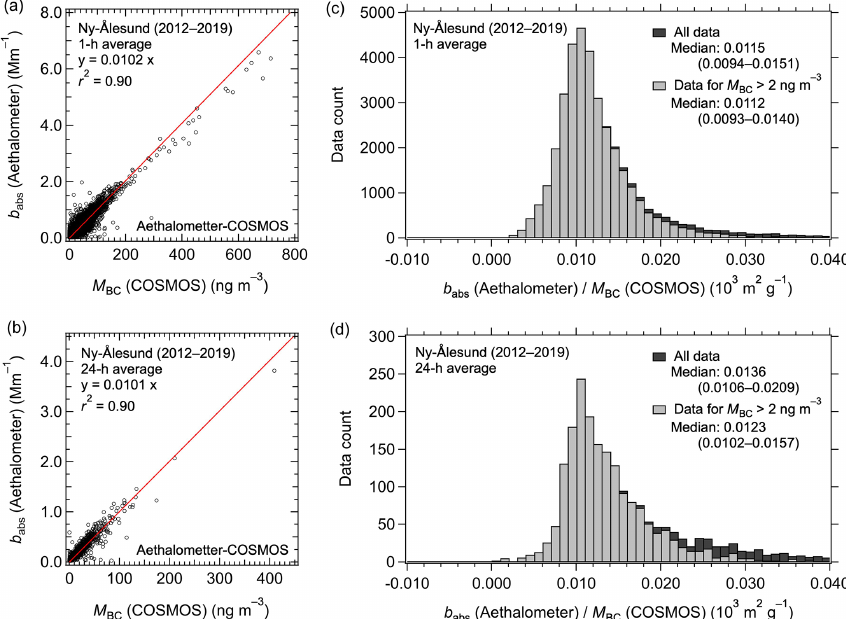
Figure 8. Correlations of M BC (COSMOS) and b abs (Aethalometer; λ = 590nm) from April 2012 to August 2019 at Ny-Ålesund for (a) 1h averaged and (b) 24h averaged data. The solid red lines are the least-squares regressions forced through the origin. (c, d) Corresponding histograms of b abs (Aethalometer) /M BC (COSMOS) ratios for all data and data with M BC (COSMOS) > 2ngm − 3 .